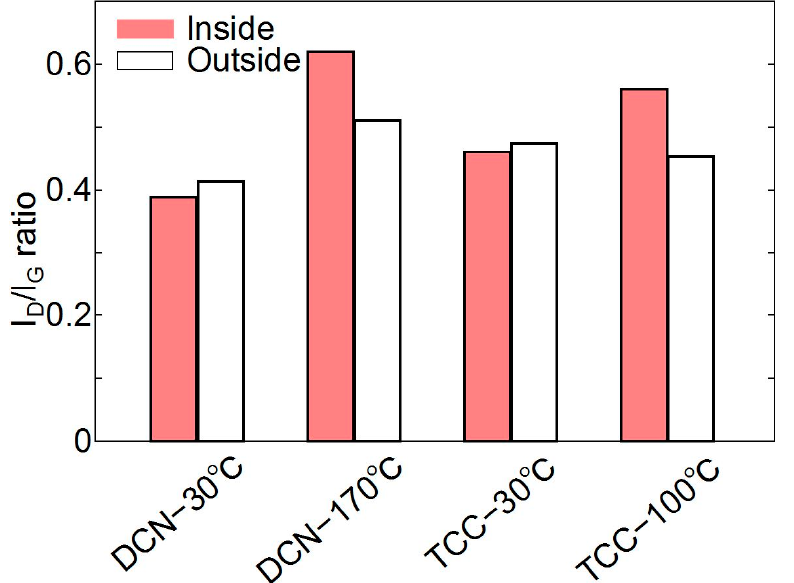
Figure 7. I D / I G ratio of (BMIM)(DCN) and (BMIM)(TCC).